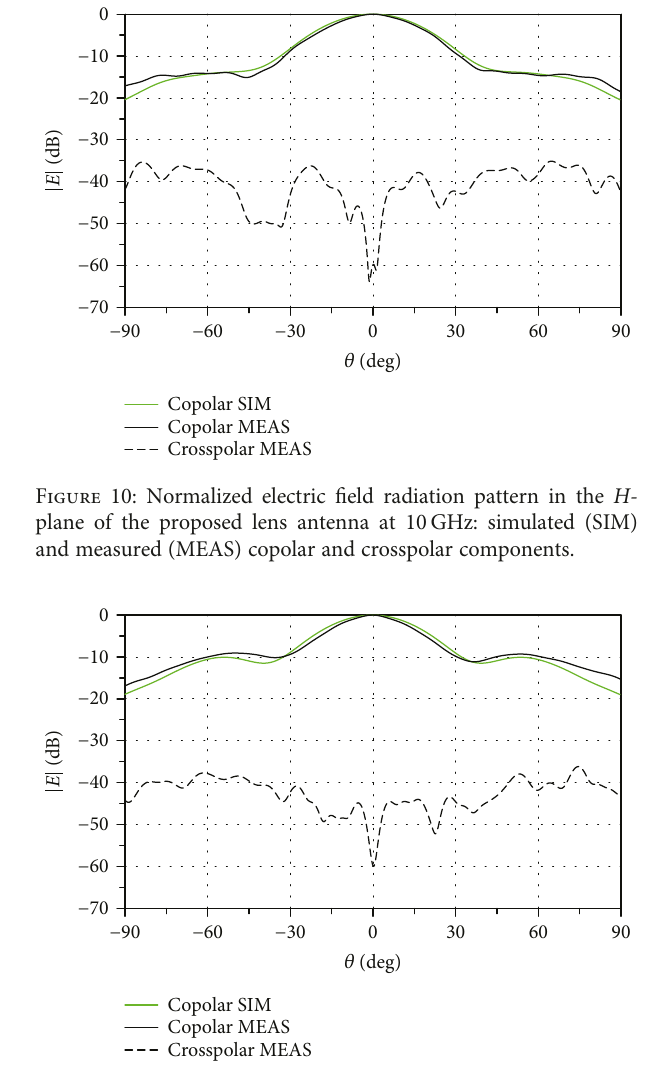
Figure 11: Normalized electric fi eld radiation pattern in the E -plane of the proposed lens antenna at 10GHz: simulated (SIM) and measured (MEAS) copolar and crosspolar